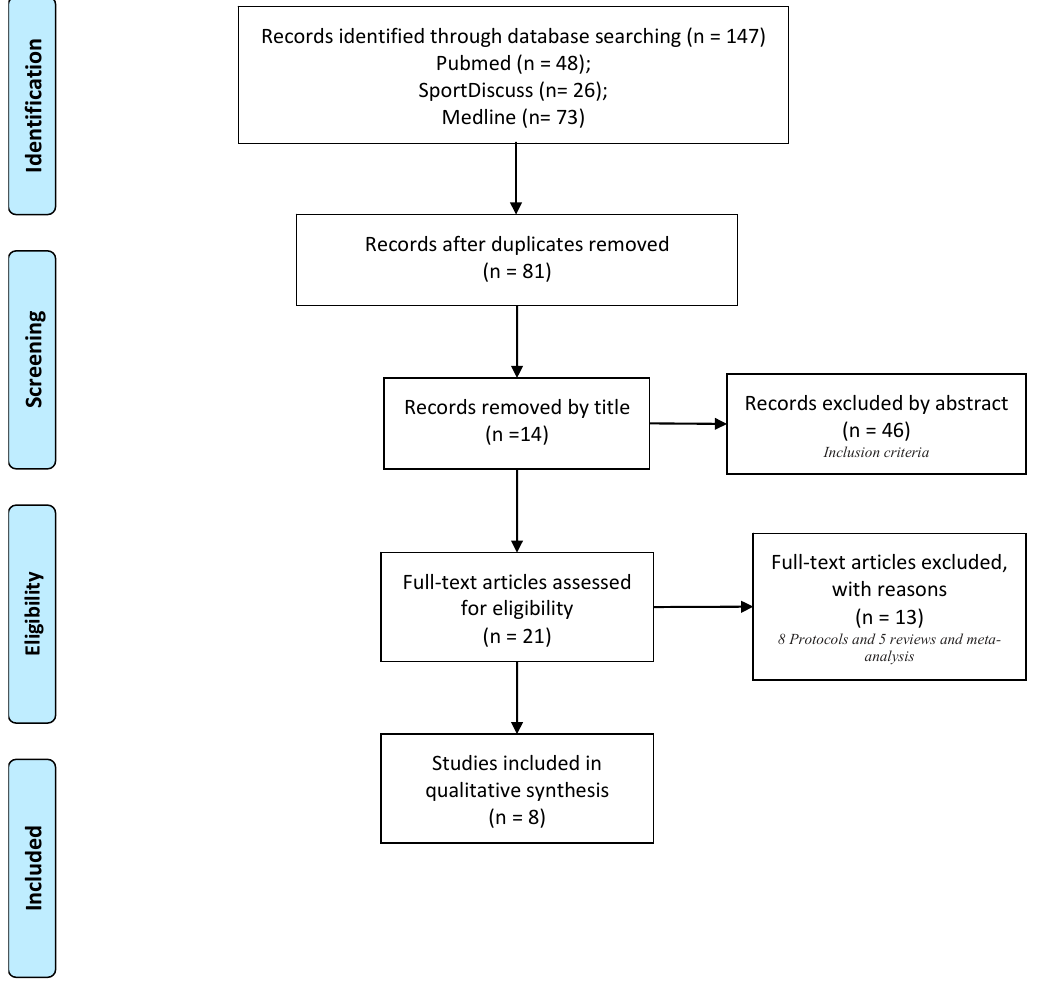
Figure 1. PRISMA flow-chart.